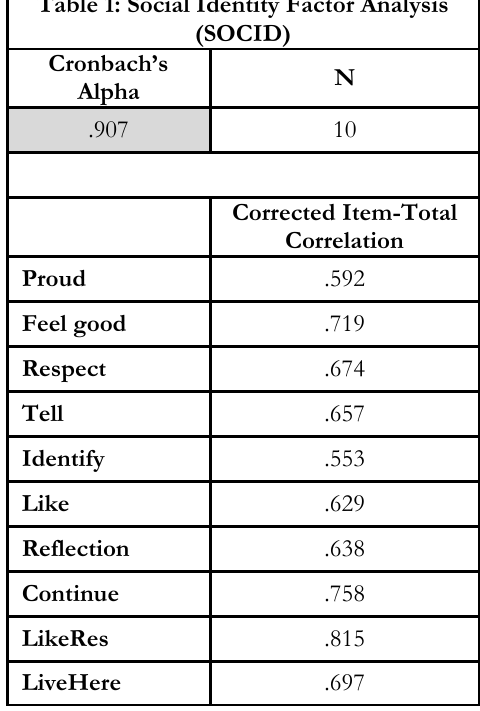
Table 1: Social Identity Factor Analysis Table 2: Intent to Inshop Factor